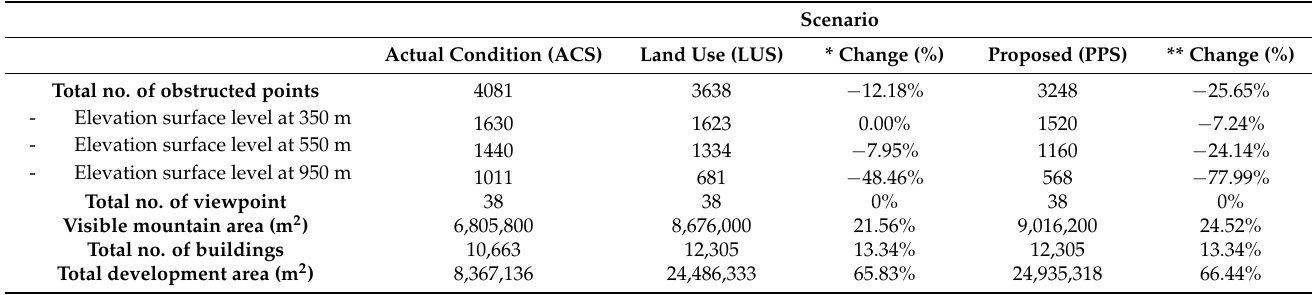
Table 4. Results of the linear line of sight and viewshed analysis, the area calculation, and change (%). Scenario Actual Condition